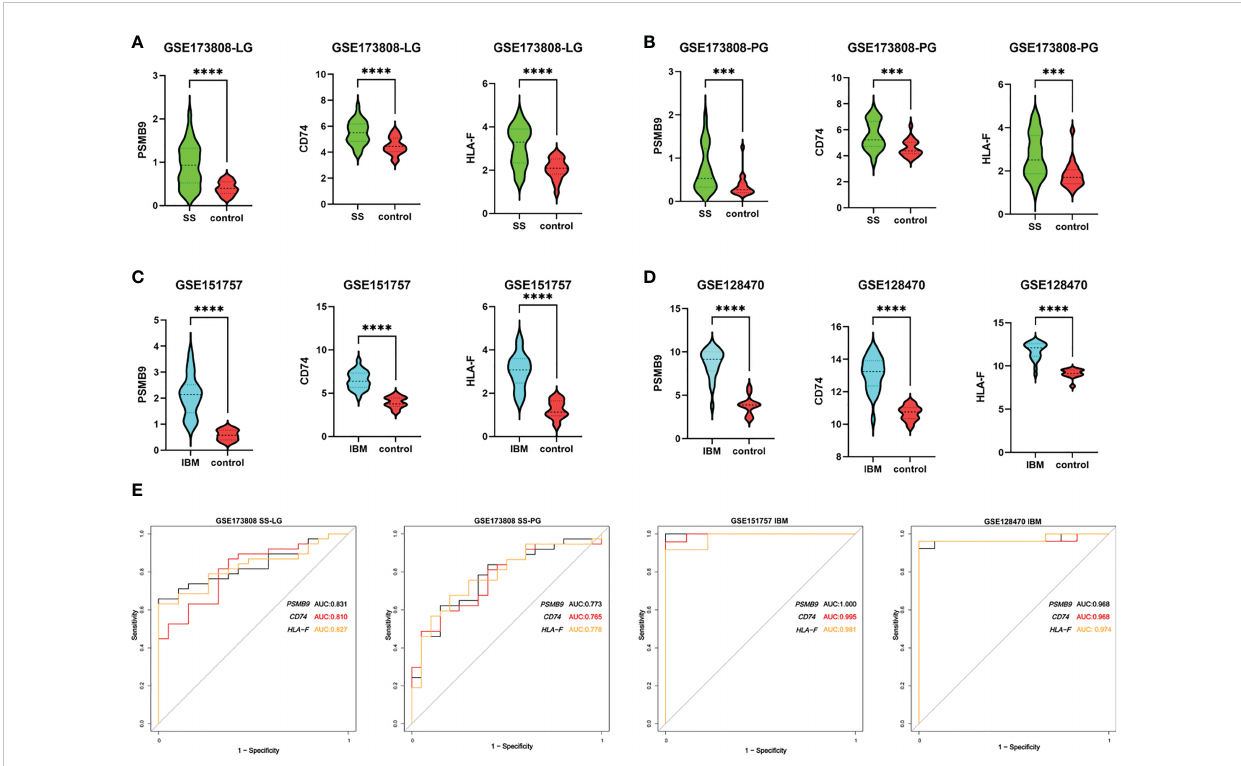
FIGURE 5 Expression levels and diagnostic values of hub genes. (A) The expression of PSMB9 , CD74 and HLA-F in labial gland tissues of SS (n=38) compared with controls (n=19) in the GSE173808 dataset. (B) The expression of PSMB9 , CD74 and HLA-F in parotid gland tissue samples of SS patients (n=37) compared with controls (n=20) in the GSE173808 dataset. (C) The expression of PSMB9 , CD74 and HLA-F in muscle samples of IBM patients (n=24) compared with controls (n=9) in the GSE151757 dataset. (D) The expression of PSMB9 , CD74 and HLA-F in muscle samples of IBM patients (n=26) compared with controls (n=12) in the GSE128470 dataset. The two groups were compared using a nonparametric Student ’ s t test with a P value of 0.05. *** p <0.001; **** p <0.0001; (E) The ROC curves of PSMB9 , CD74 and HLA-F in the four datasets. SS, Sjögren syndrome; IBM, inclusion body myositis. LG, labial gland; PG, parotid